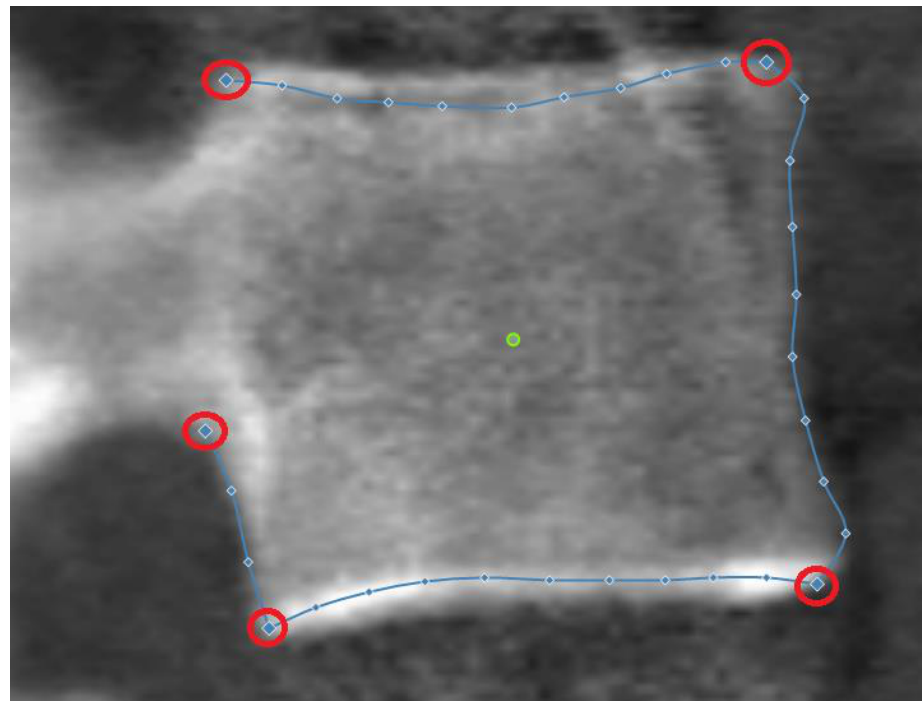
Figure 2. The five reference points, one on each corner and the fifth one on the pedicle of the vertebra.